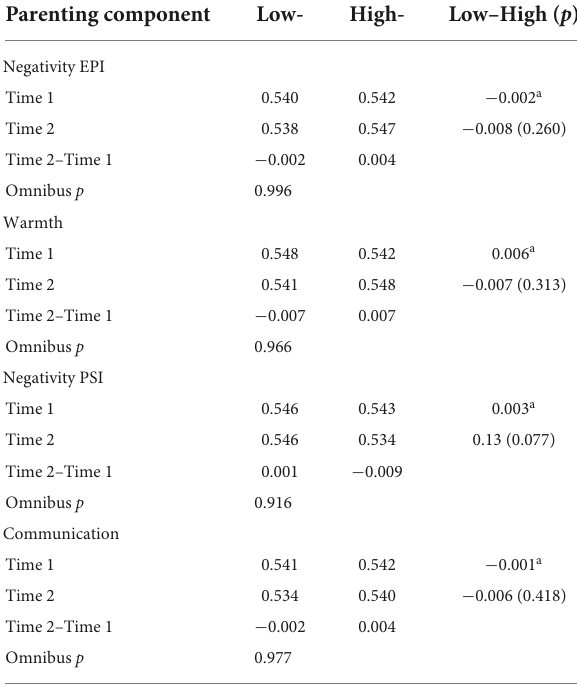
TABLE 4 Global efficiency and group differences for low- and high-parenting components, time 1 and 2 ( n = 114). Parenting